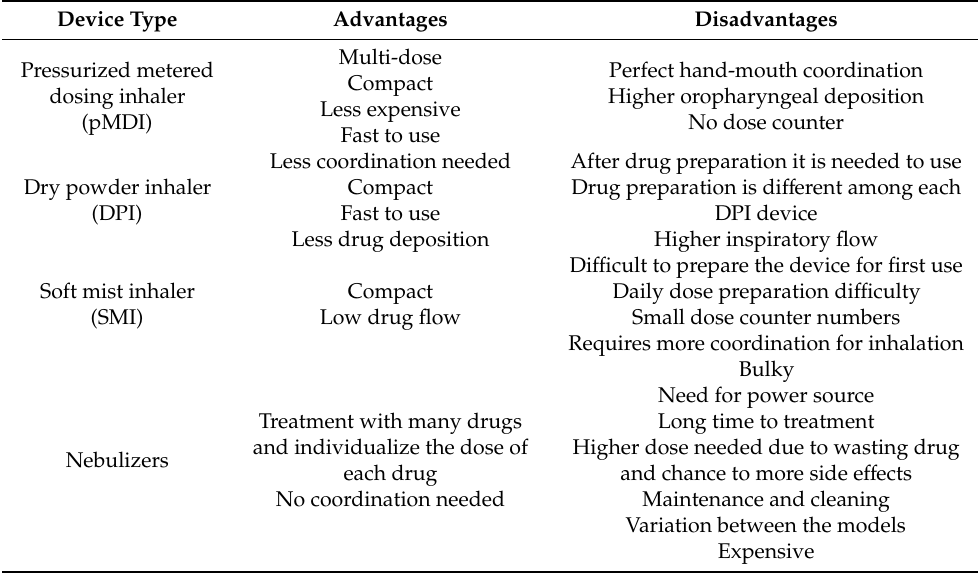
Table 1. Advantages and disadvantages of inhaler